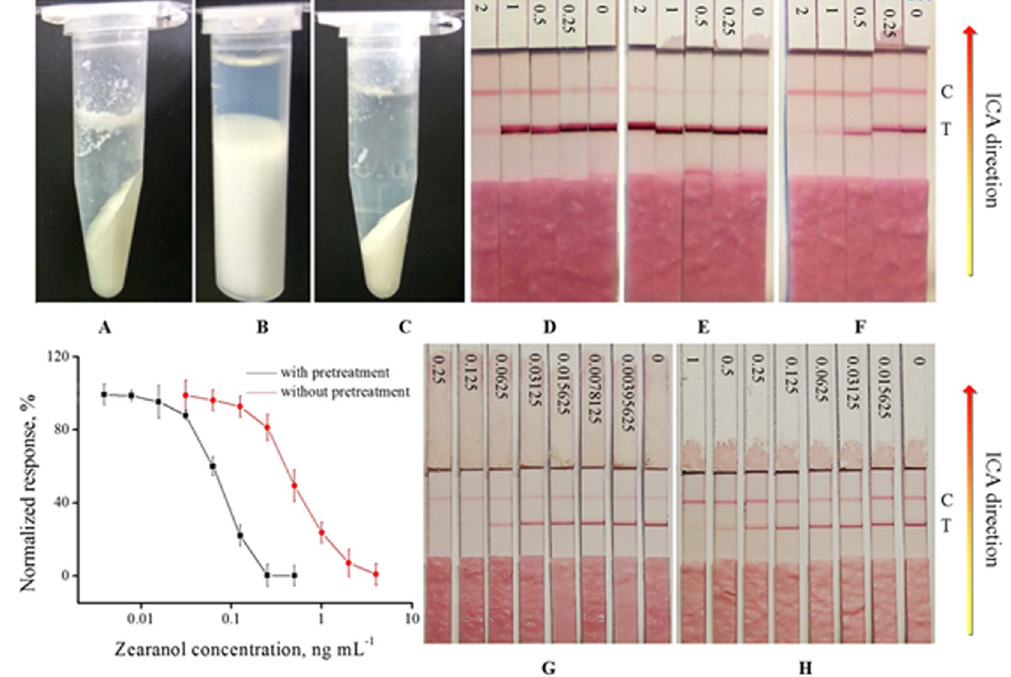
Figure 3. Supernatant (upper layer) of spiked milk samples obtained after pretreatment: acid-base method ( A ), organic solvent method ( B ), heavy metal salt method ( C ). ICA result of zearanol spiked milk with acid-base method ( D , G ), heavy metal salt method ( E ), and without pretreatment ( F , H ). The spiked concentrations were 2, 1, 0.5, 0.25, and 0 μ g L − 1 for ( D – F ); 0.25, 0.125, 0.0625, 0.03125, 0.015625, 0.0078125, 0.00395625, and 0 μ g L − 1 for ( G ); and 1, 0.5, 0.25, 0.125, 0.0625, 0.03125, 0.015625, and 0 μ g L − 1 for ( H ) (left to right). The C and T on the right side represent the control and test lines, respectively. The calibration for zearanol spiked milk with and without pretreatments is shown in the lower left. The strips for zearanol in ( D – H ) were form different